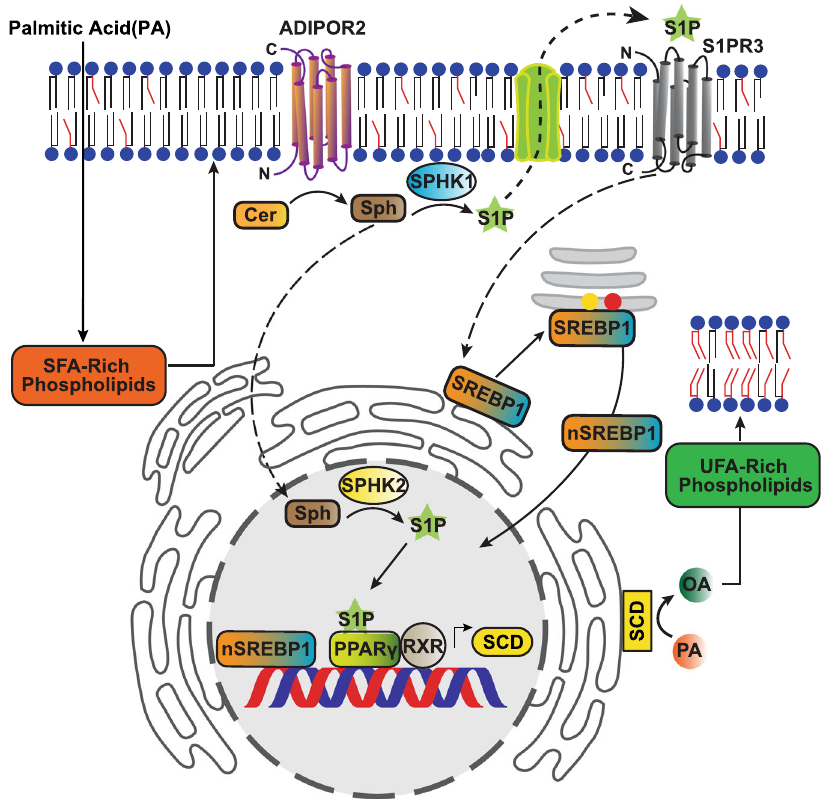
Fig. 7 | Model. Membrane rigidi fi cation activates a ceramidase activity intrinsic to AdipoR2, resulting in the generation of sphingosine 1-phosphate (S1P) that sepa- rately activates the SREBP1 and PPAR γ transcription factors. SREBP1 and PPAR γ